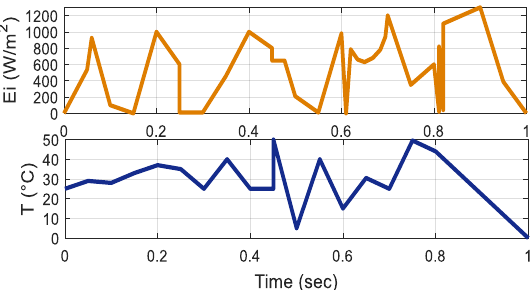
Figure 16. Variable irradiance and temperature signals used to evaluate the performance of the RTRL and P&O controllers. and P&O